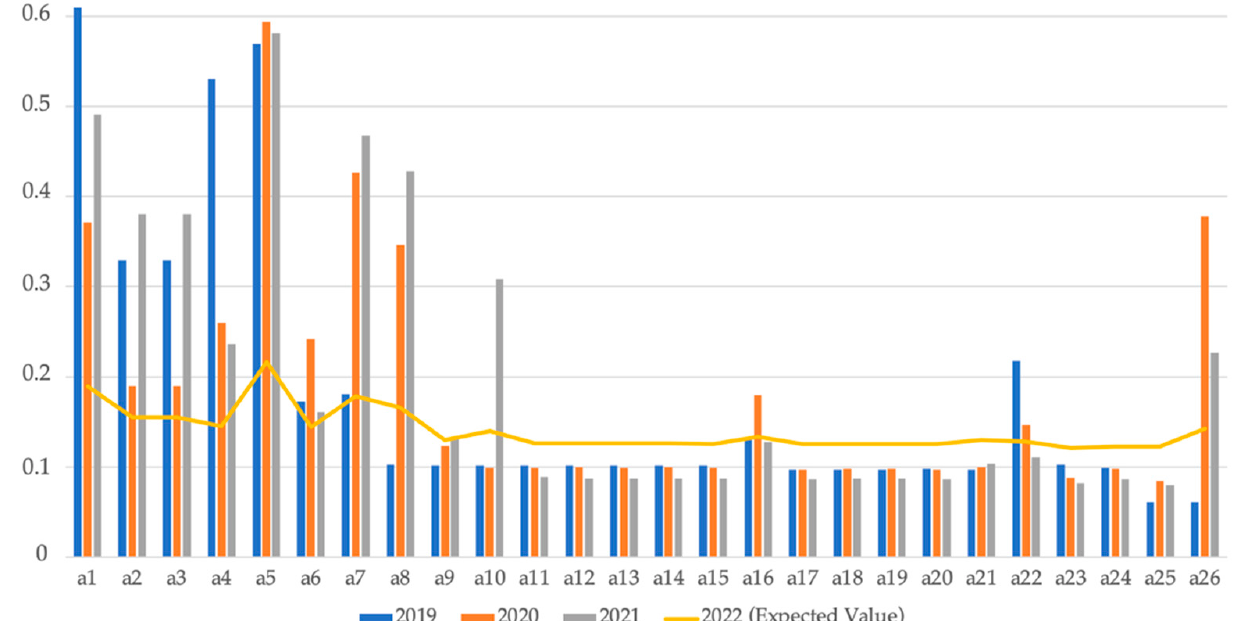
Figure 3. Comparison of alternatives ranking with integrated dynamic prospective approach.